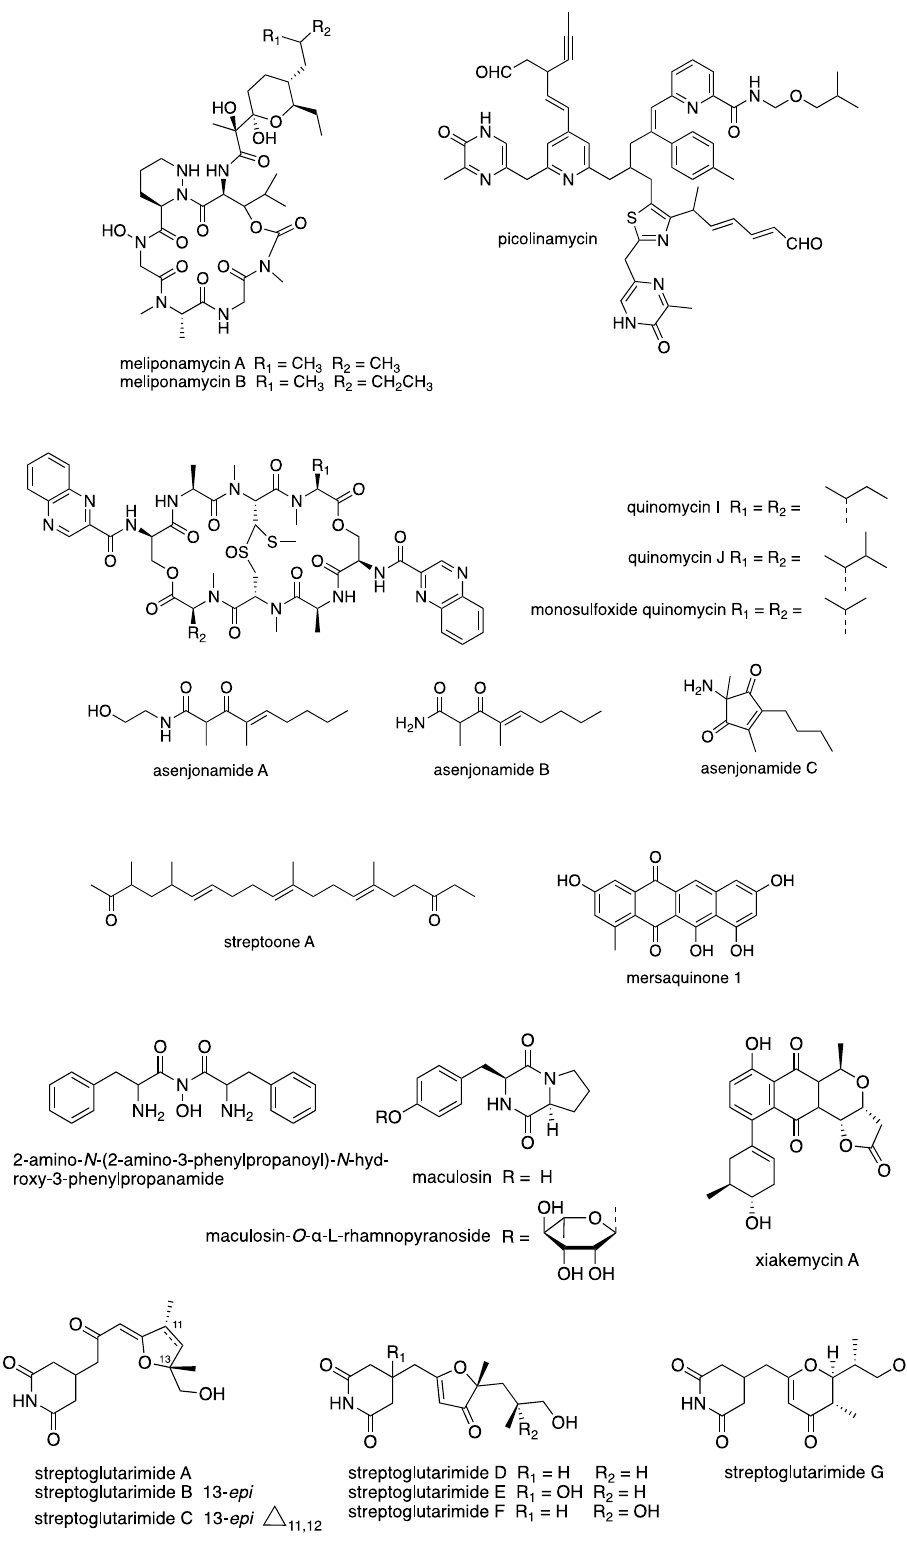
Figure 5. Examples of new compounds isolated from Streptomyces spp. between 2015 and 2020 with antibacterial activity.